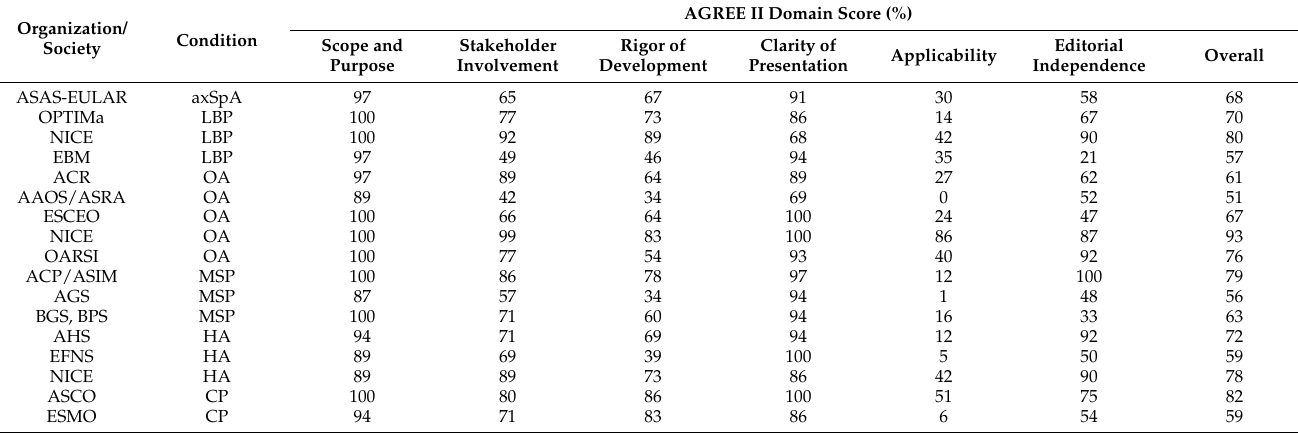
Table 2. Guideline assessment according to the AGREE II